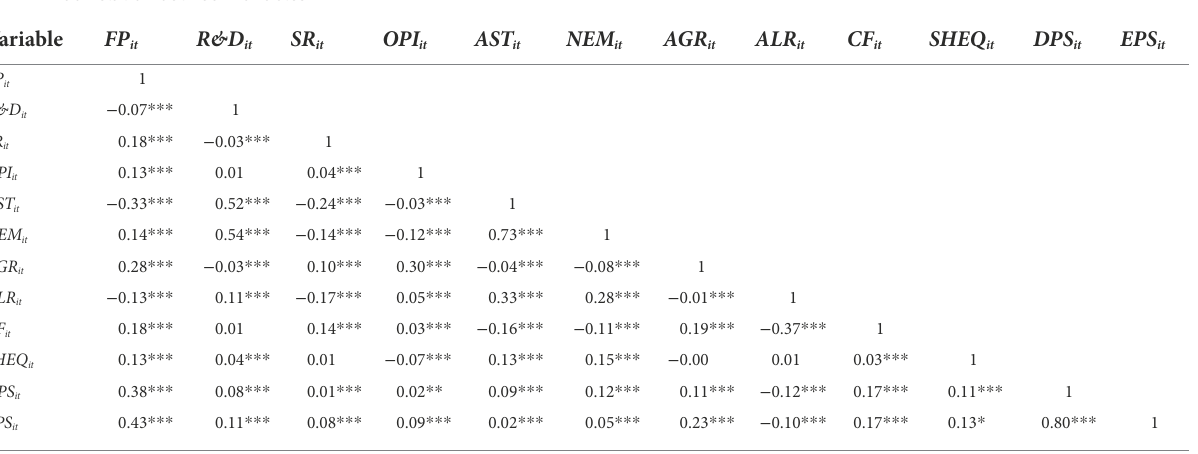
TABLE 2 Correlation between